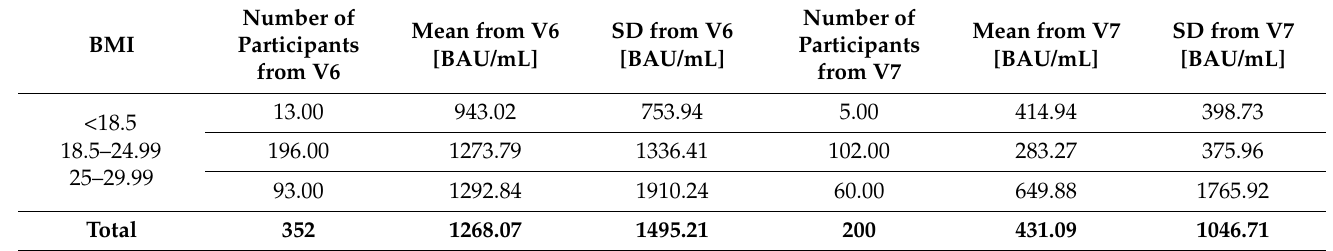
Table 3. Antibody concentration according to the BMI of the study